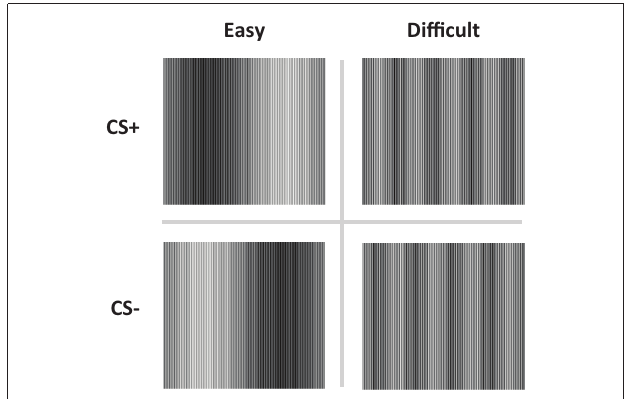
FIGURE 1 | The conditioned stimuli (CS + and CS − ) were either easy (Easy condition) or difficult to discriminate (Difficult condition) .